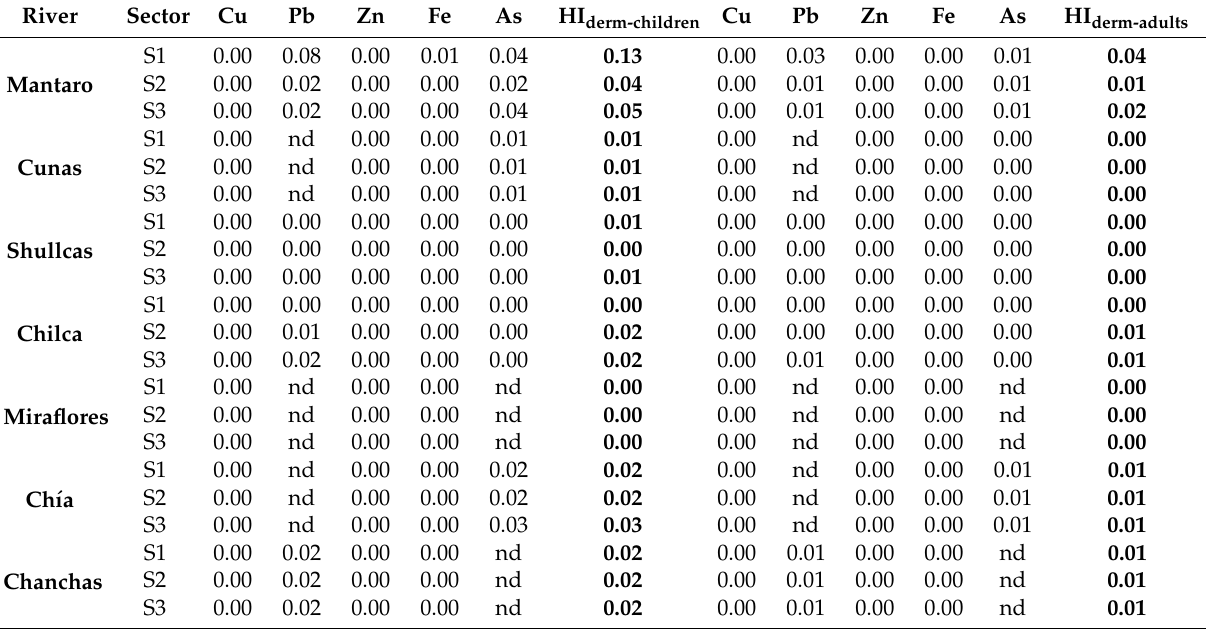
Table 4. Non-carcinogenic risk by dermal contact (HQ derm and HI derm ) of heavy metals and arsenic in river water with mining influence (children and adults).